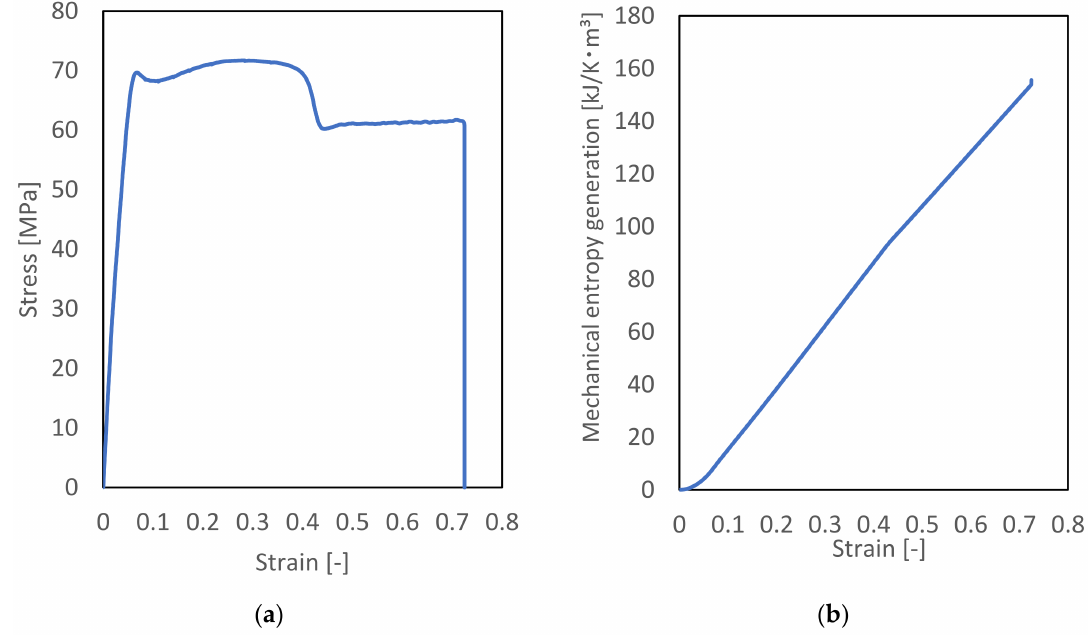
Figure 5. ( a ) Stress–strain diagram of PA6 obtained experimentally from the tensile test and ( b ) me- chanical entropy generation, calculated using experimental